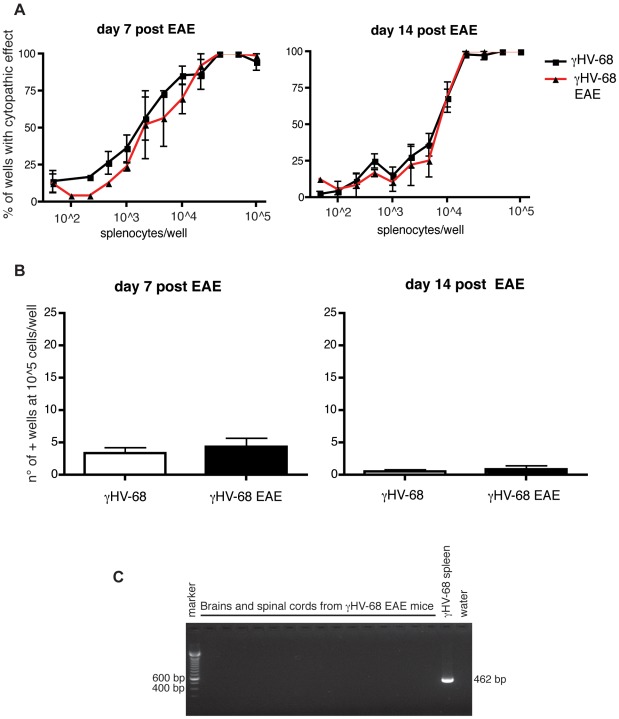
γHV-68 does not reactivate more upon EAE induction and does not infect the CNS.Mice were infected with γHV-68. Five weeks p.i., EAE was induced (red line with triangles, black bar) or not induced (black line with squares, open bar). At day 7 (left panel) and day 14 (right panel) post EAE induction, spleens were harvested and a limiting dilution assay was performed using (A) live splenocytes to assess the amount of ex-vivo viral reactivation and (B) lysed splenocytes to assess the amount of pre-formed virus (three separate experiments using 3–4 mice/group) (C) Brain and spinal cords were harvested from perfused γHV-68 EAE mice at different timepoints pre and post EAE (day 0 before EAE induction; day 3; day 7 and day 14 post EAE). DNA was extracted and a nested PCR was performed to detect γHV-68 DNA. A spleen was used as a positive control. Figure C shows a representative gel of three separate experiments (15 brains/spinal cords harvested at day 14 post EAE induction have been loaded on the gel displayed here; 37 brains and 39 spinal cords were analyzed in total).